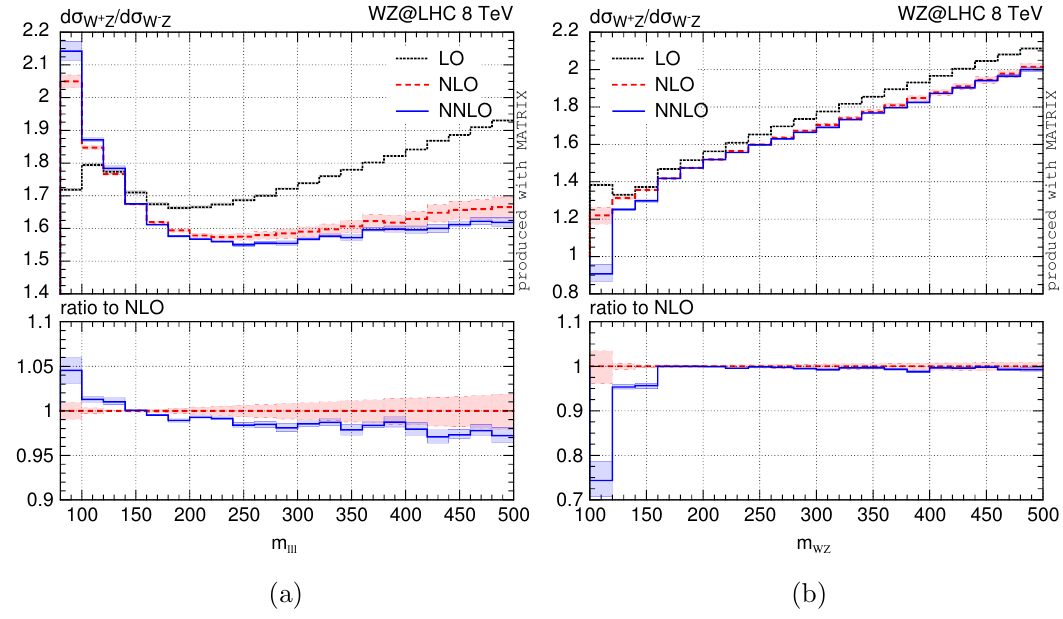
Figure 10 . Ratio of W + Z and W (cid:0) Z distributions in the (a) invariant mass of the three leptons and (b) invariant mass of the WZ